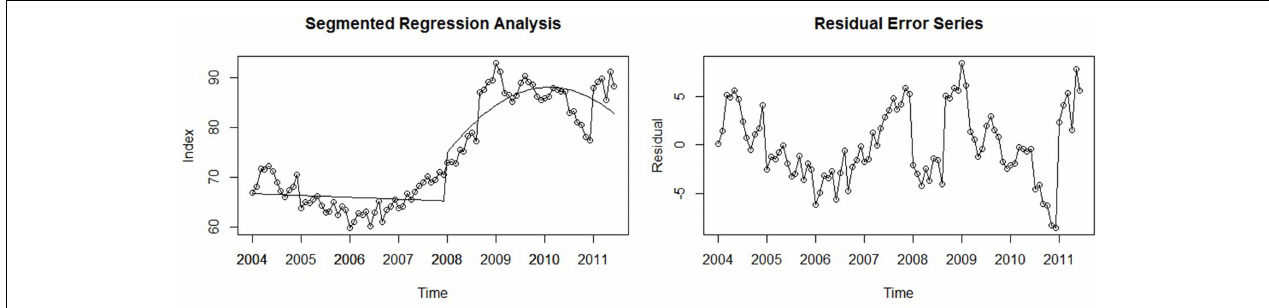
FIGURE 7 | A segmented regression model used to assess the effect of the 2008 economic crisis on the time series and its associated residual error series.